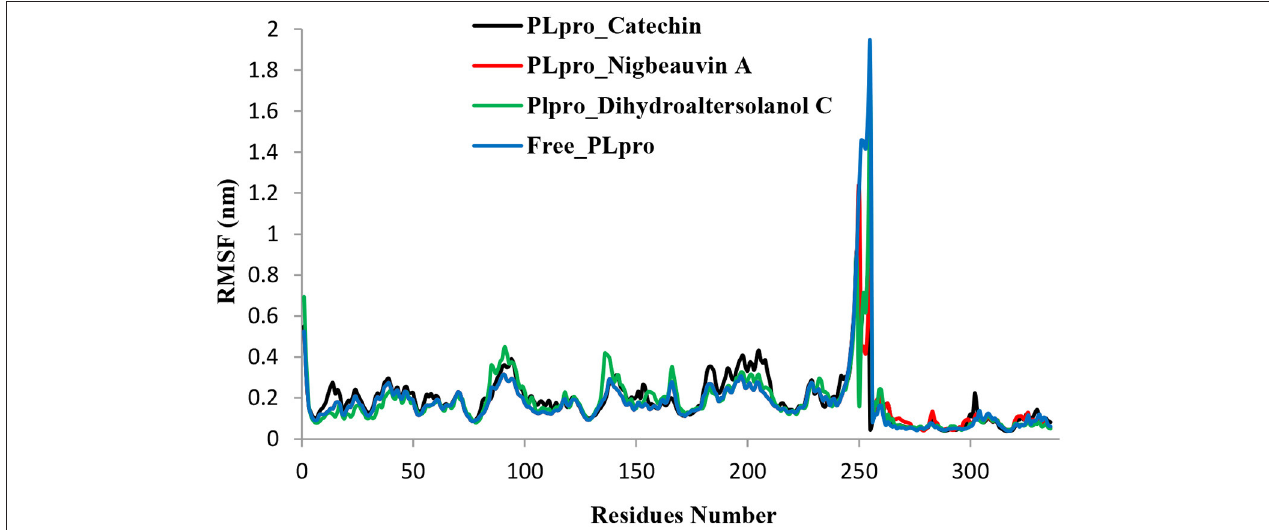
FIGURE 5 | Time series for the flexibility analysis of the amino acid residues for the PLpro-ligand complex and Free-PLpro alpha carbon atom simulated systems. PLpro-Catechin code: black, PLpro-Nigbeauvin A code: red, PLpro-Dihydroaltersolanol C code: green, and Free-PLpro code: blue.